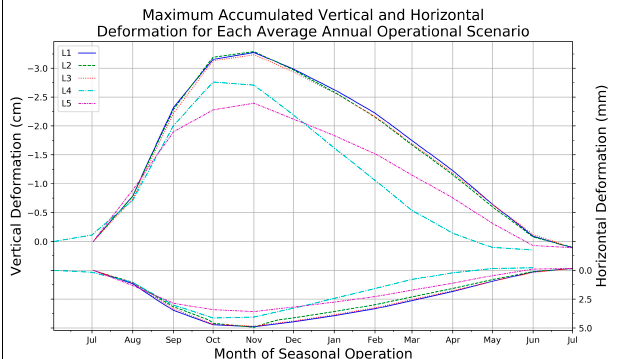
and June 1 are the first days in each scenario in which there is net positive reservoir storage. Fig. 5